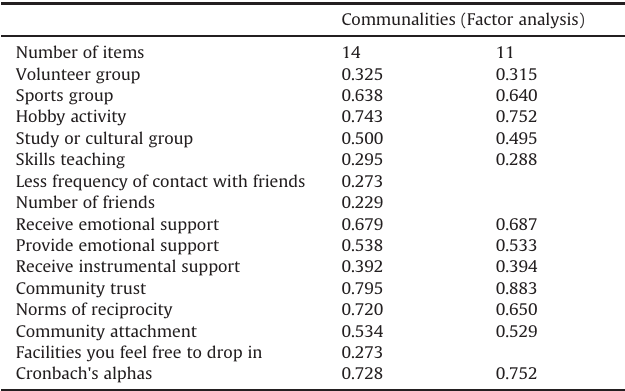
Table 2 Extraction of social capital candidate indicators based on reliability.